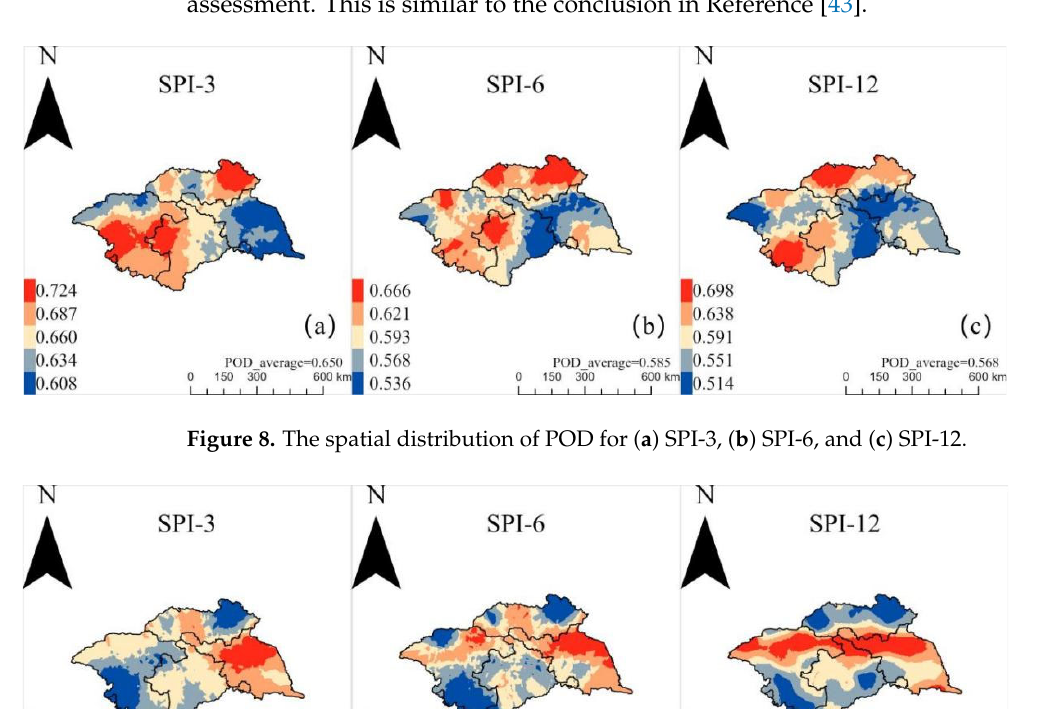
Figure 8. The spatial distribution of POD for ( a ) SPI ‐ 3, ( b ) SPI ‐ 6, and ( c ) SPI ‐ 12.